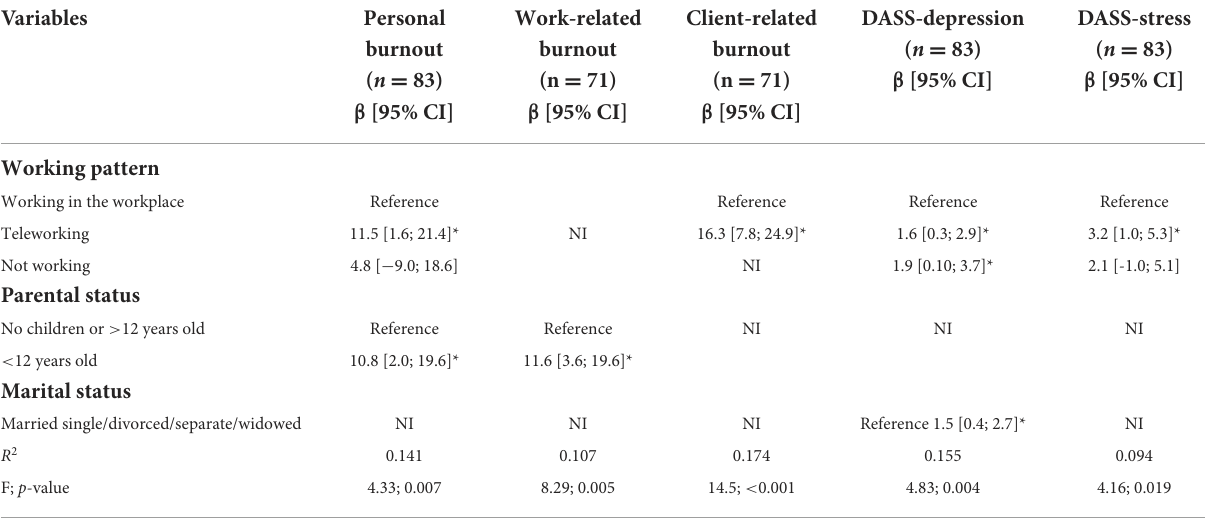
TABLE 4 Regression coefficients, from univariate multiple linear regressions.